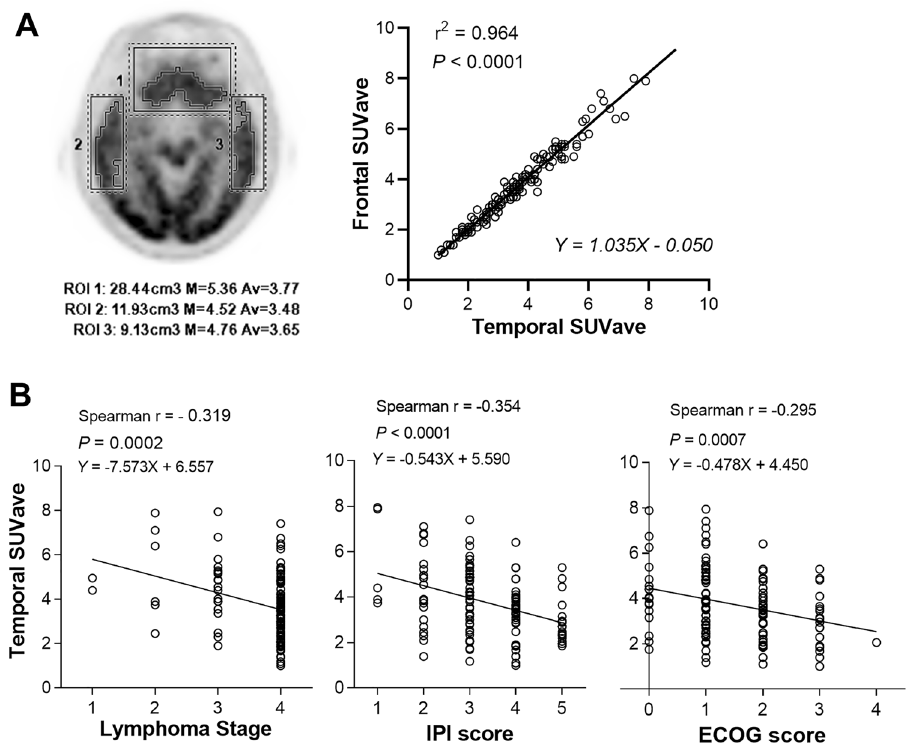
Figure 3. Relationship between brain FDG uptake and lymphoma status. ( a ) Illustration of volumes of interest (VOIs) placed on frontal and temporal lobes (left), and excellent concordance between frontal and temporal cortex uptake levels (right). Cortical boundaries were defined as 40% of the maximum activity. ( b ) Relations between temporal cortex FDG uptake with lymphoma stage (left), IPI risk score (middle), and ECOG performance (right). SUVave, average standard uptake value; ECOG, Eastern Cooperative Oncology Group; IPI, International Prognostic Index.